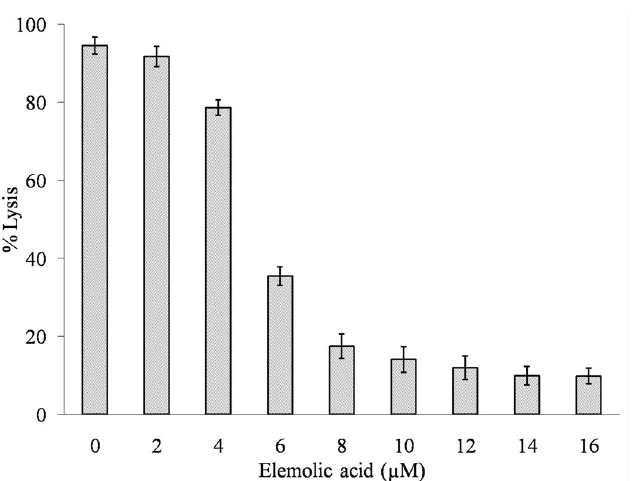
Figure 10. Neutralization of indirect hemolytic activity of GIIA by elemolic acid. The GIIA enzyme was pre-incubated with indicated concentrations of elemolic acid for 15 min. The reaction was initiated by adding 1 mL of the substrate (erythrocytes, egg yolk, and PBS -1: 1: 8 V/V) and incubated for 30 min at 37 °C. The hemoglobin released due to hemolysis was measured at 540 nm. The reaction mixture without enzymes served as a positive control. The data represents mean ± SD (n =